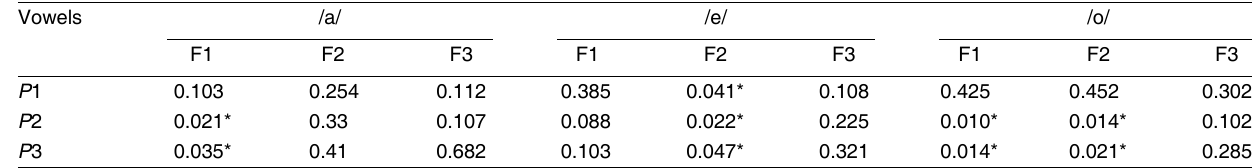
techniques; F, formant frequency; *Signi (cid:383) cant when P (cid:365) 0.05.